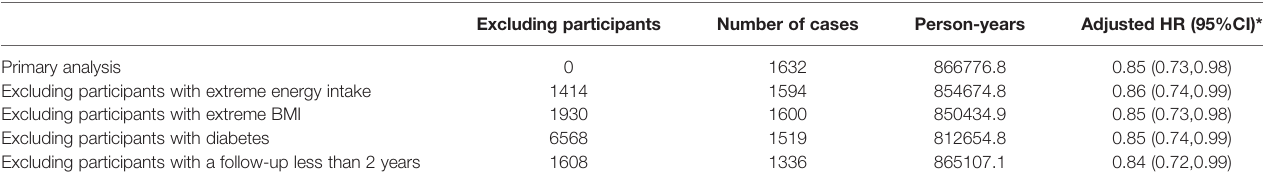
TABLE 3 | Sensitivity analyses to assess the robustness of the association between DRRD score and lung